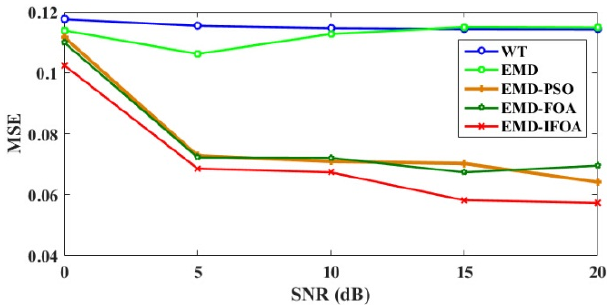
Figure 8. The mean squared error of the five methods in different SNRs. MSE: mean squared error. Appl. Sci. 2017 , 7 , 215